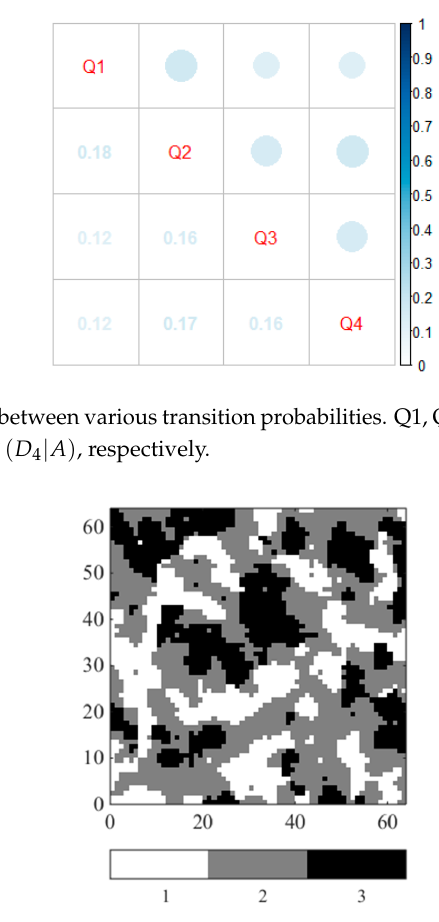
Figure 2. Reference map with dimension 64 × 64 and three categories.